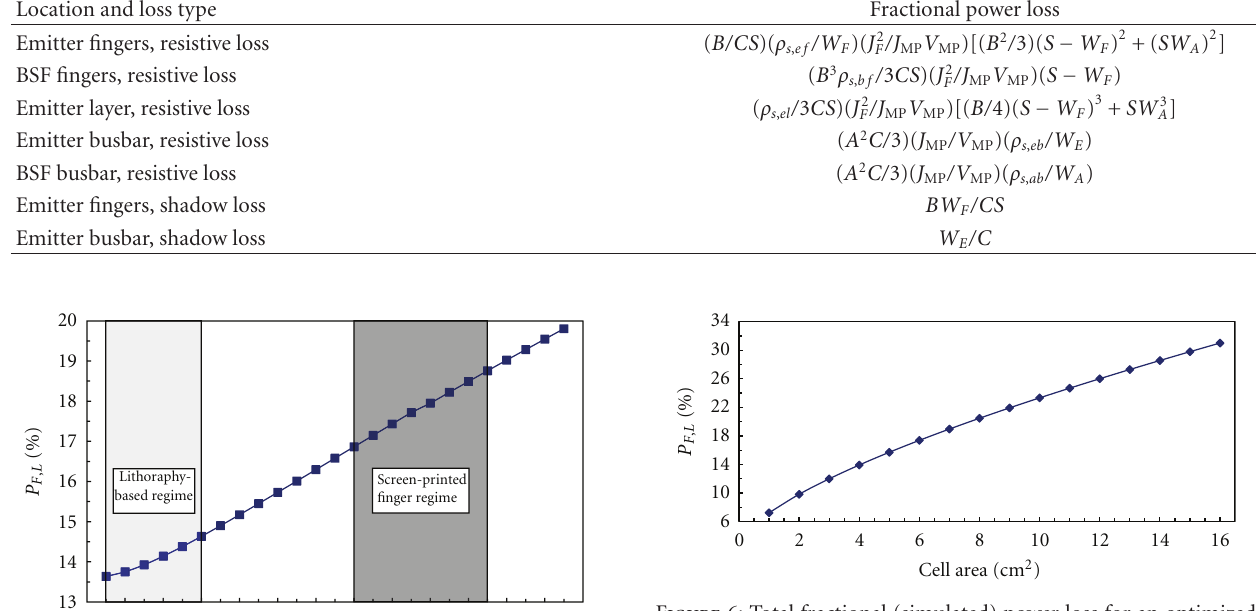
Figure 6: Total fractional (simulated) power loss for an optimized interdigitated thin-film solar cell on glass, as a function of total cell size. The cell dimensions for each cell area datum have also been optimized. A constant minimum emitter finger width of 15 μ m, maximum power point current density of 25 mA/cm 2 , an open- circuit voltage of 400 mV, and an emitter layer sheet resistivity of 400 Ω / (cid:2) have been assumed for this